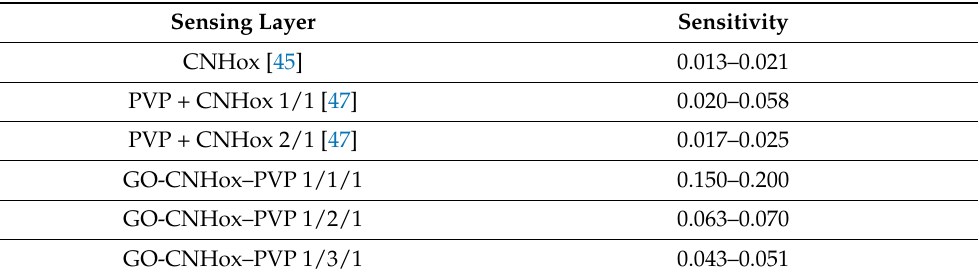
Table 1. Sensitivity of GO-CNHox–PVP compared with previously tested sensing layers